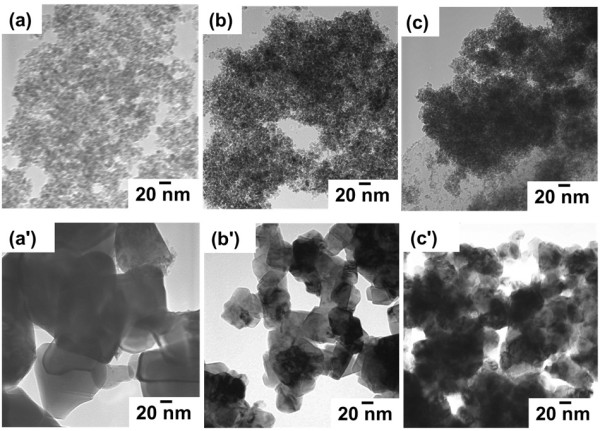
TEM images of fresh and calcined samples. Fresh samples: (a) CeO2, (b) Ce0.5Zr0.5O2, and (c) Ce0.5Zr0.3Al0.2O1.9. Calcined samples: (a') CeO2, (b') Ce0.5Zr0.5O2, and (c') Ce0.5Zr0.3Al0.2O1.9.